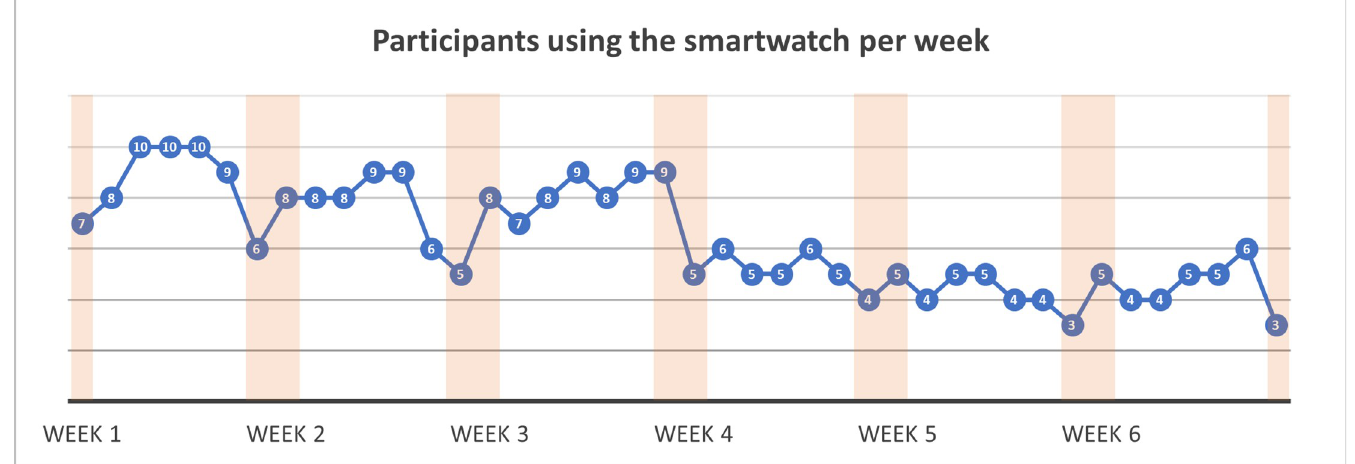
Fig 2. Participants wearing smartwatch per day. Number of participants who wore the watch each day. Orange bars represent